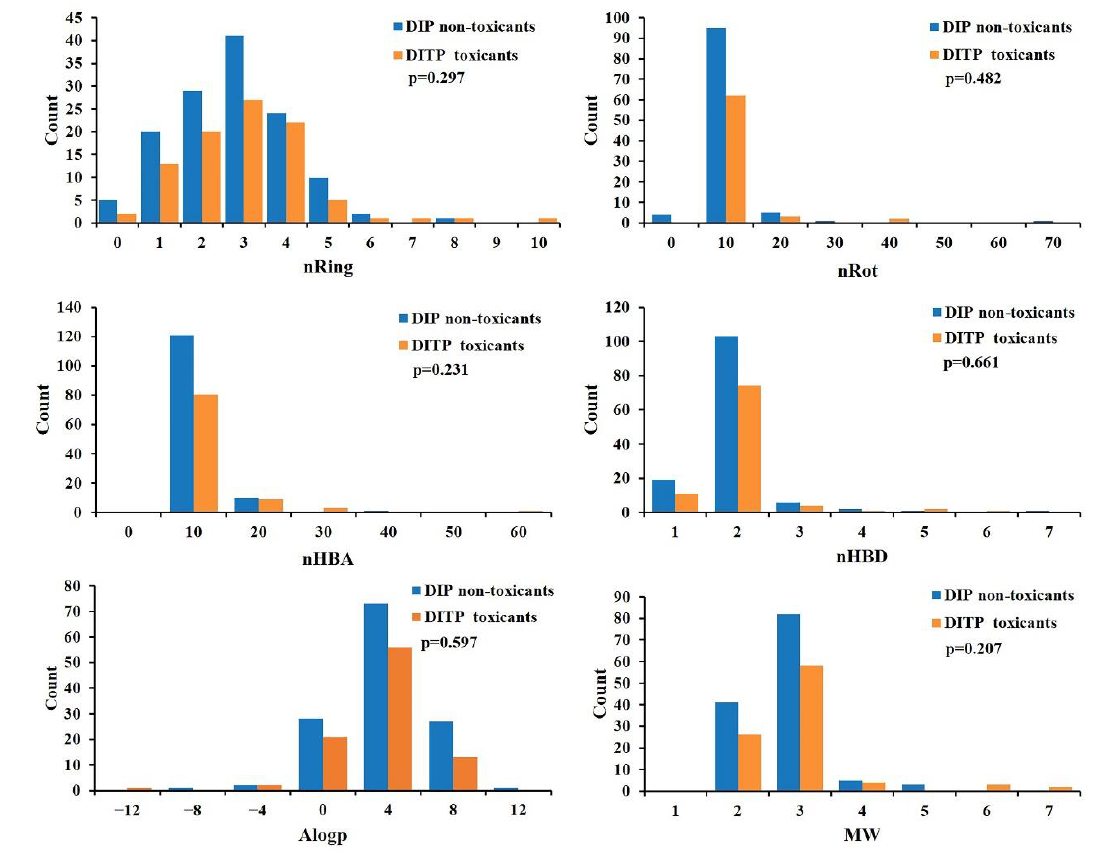
Figure 2. Distributions of six molecular properties of DITP toxicants and DITP non-toxicants.